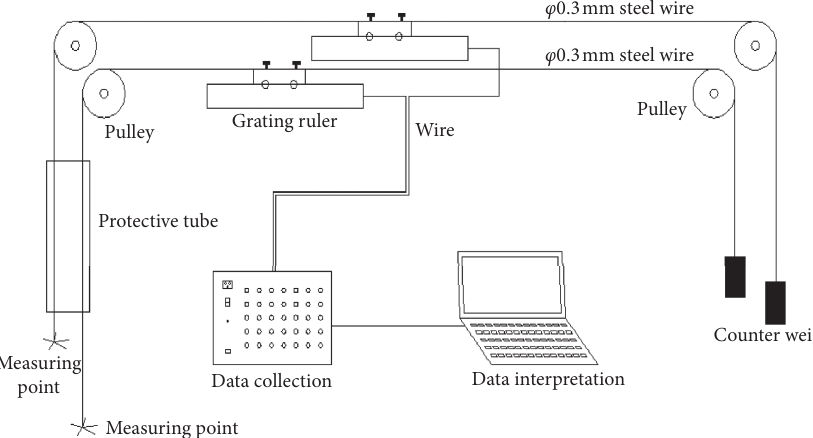
Figure 10: Principle diagram of the grating multipoint extensometer measurement